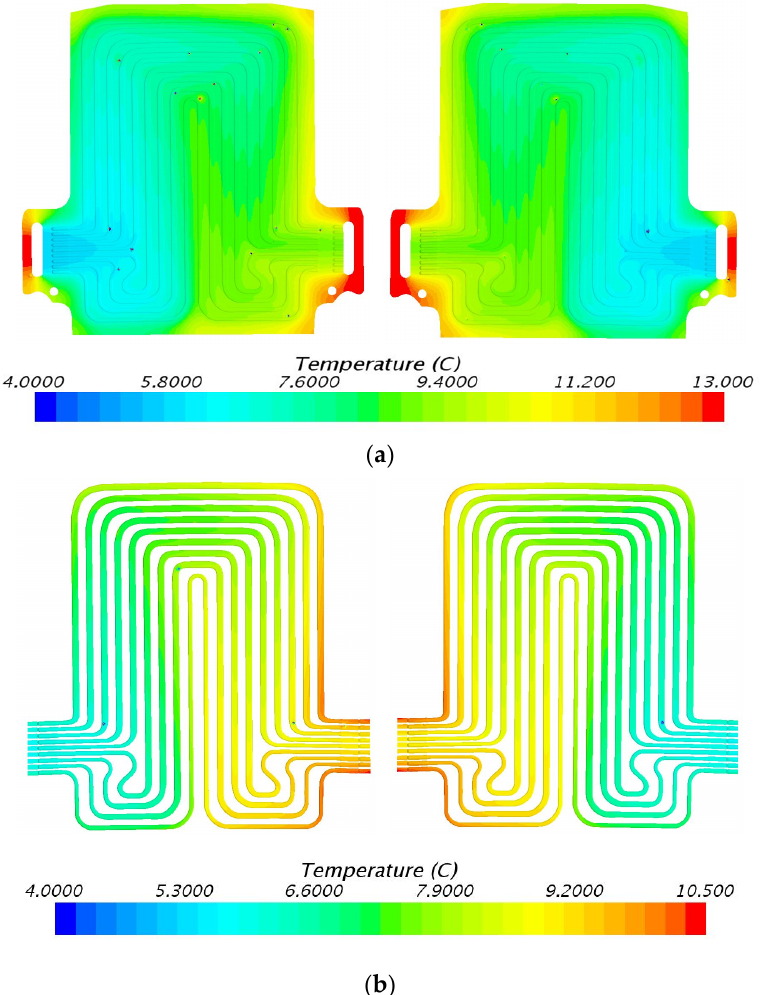
Figure 7. Temperature profile at 60 A and 5 ◦ C with heat flux values near cathode = 2347.7 W / m 2 , anode = 2259.5 W / m 2 , and mid surface = 539.3 W / m 2 . ( a ) Top view and ( b ) bottom view.